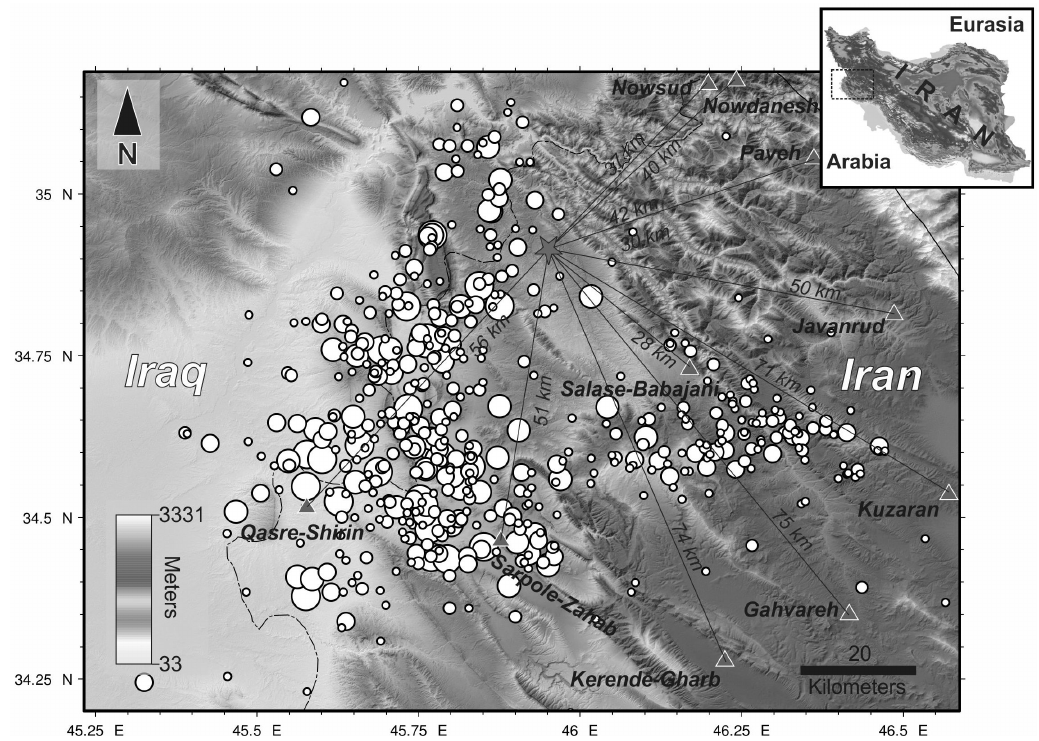
Figure 1. Shaded relief map of the study area showing the locations of the epicenter (star) and aftershocks (~700 white circles) greater than magnitude 2 from 12 November 2017 to 1 December 2017 recorded by the Iranian Seismological Center. The triangles are the surrounding towns. The thin lines show the Euclidean distances between each town and the epicenter. The inset map shows the topography of